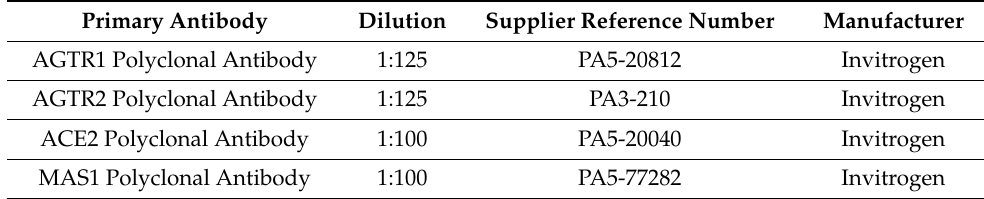
Table 2. Description of primary